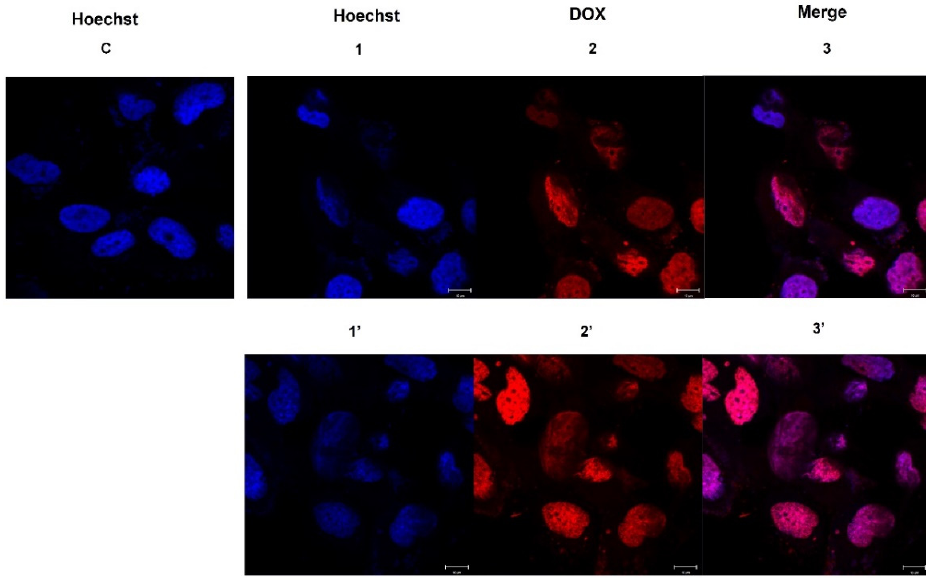
Figure 4. Representative images of confocal microscopy analysis of an HS578T cell line treated with NPs-HSA@DOX. ( C ) Control; ( 1-3 ) MelaSil_Ag-HSA@DOX 3 h; ( 1 ′ -3 ′ ) MelaSil_Ag-HSA@DOX 6 h. Cell nuclei were stained with Hoechst 33258; DOX is visible as red color. Scale bar: 10 µm.